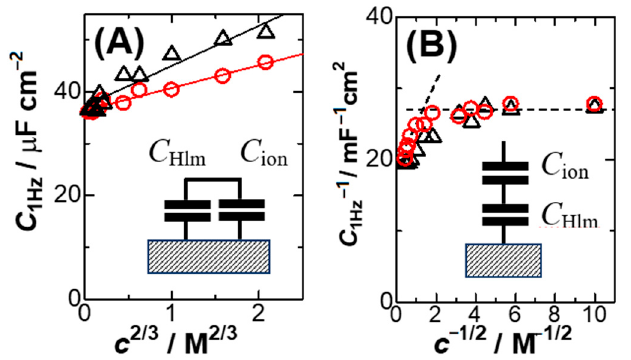
Figure 4. Plots of ( A ) C 1Hz vs. c 2/3 and ( B ) 1/ C 1Hz vs. c − 1/2 in (circles) KCl and (triangles) HCl solutions. ( A ) is the parallel model by Equation (6), whereas ( B ) is the series (Stern) model by Equation (7).